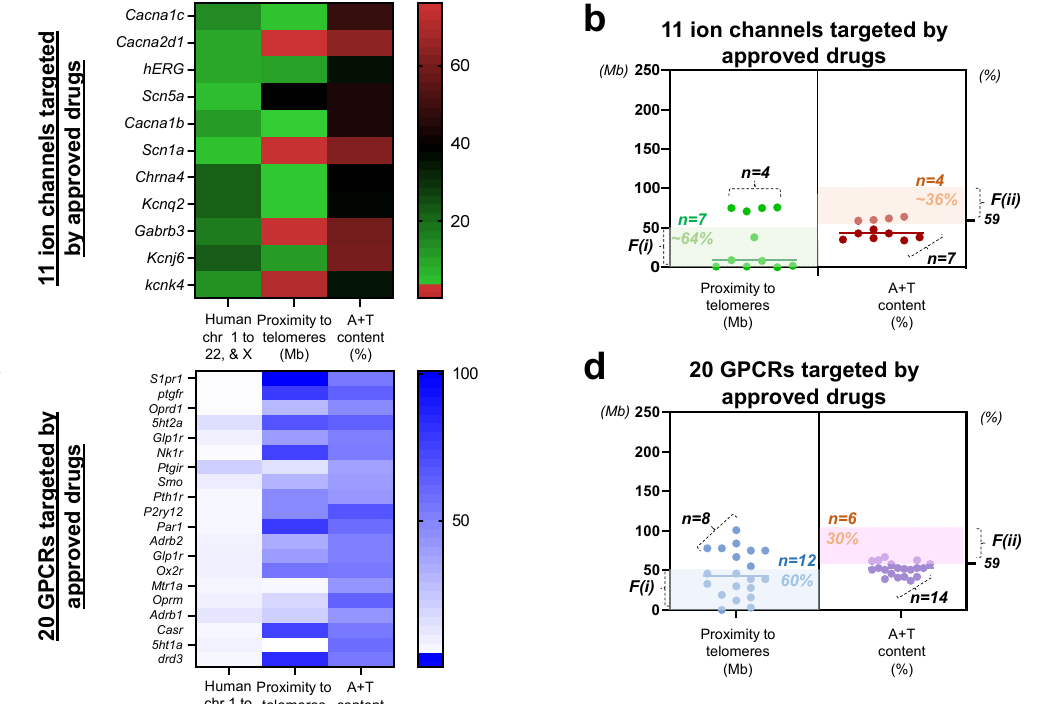
Figure 4. Relative mutability of ion channels and GPCRs targeted by approved drugs ( a ) the color- coded map illustrating distributions of 11 genes encoding ion channels targeted by commercialized drugs with respect to the human chromosome 1 through 22 and X (color code range 1 to 23), proximity to telomeres (range 0 to 100), and A+T content (range 0 to 100), respectively. Note that all 11 genes are marked on the left (y) axis. The reference number with coded color is shown on the right ( b ) scatter plots displaying relative mutability of 11 ion channels by proximity to telomeres ( left ) and A+T content ( right ). Shaded regions with light green ( left ) and light brown ( right ) demonstrate genes satisfying either of the two factors. Note that genes outside the shaded regions ( n = 4 by F(i); n = 7 by F(ii)) are relatively less mutable. ( c ) the color ‐ coded map illustrating distributions of 20 genes encoding GPCRs with respect to the human chromosome 1 through 22 and X (color code range 1 to 23), proximity to telomeres (range 0 to 100), and A+T content (range 0 to 100), respectively. Note that all 20 genes are marked on the left (y) axis. The reference number with coded color is shown on the right ( d ) scatter plots exhibiting relative mutability of 20 GPCRs by proximity to telomeres ( left ) and A+T content ( right ). Shaded regions with light blue ( left ) and light brown ( right ) show genes satisfying either of the two factors. Note that genes outside the shaded regions ( n = 7 by F(i); n = 15 by F(ii)) are relatively less mutable.